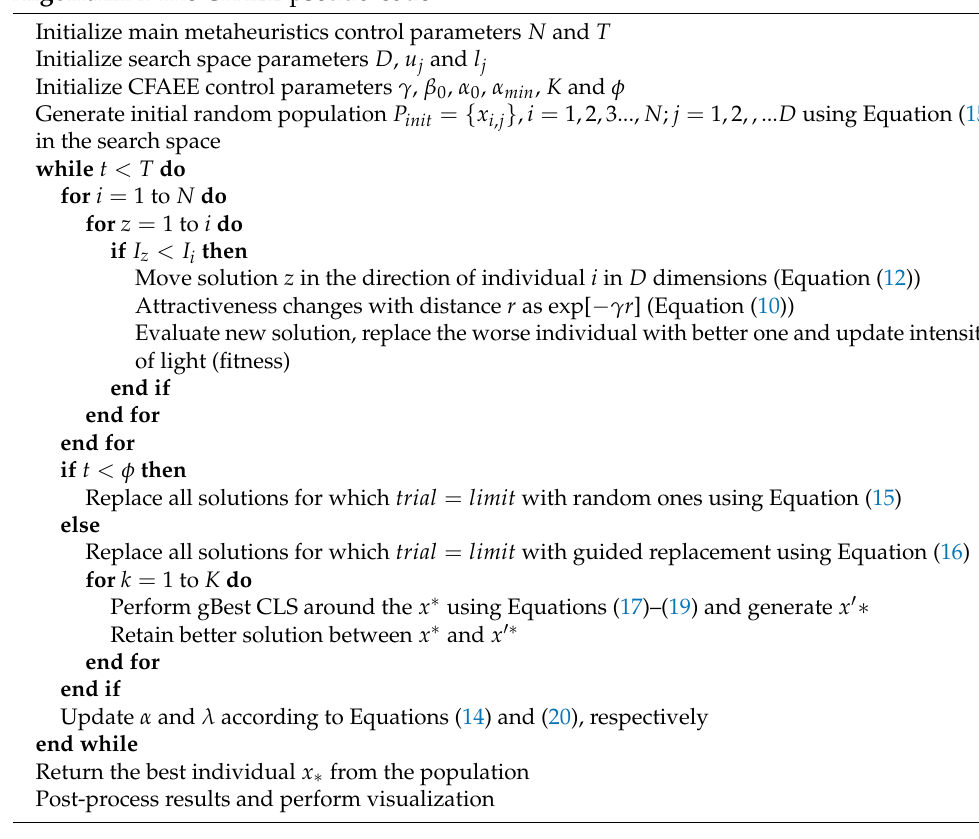
Algorithm 1 The CFAEE